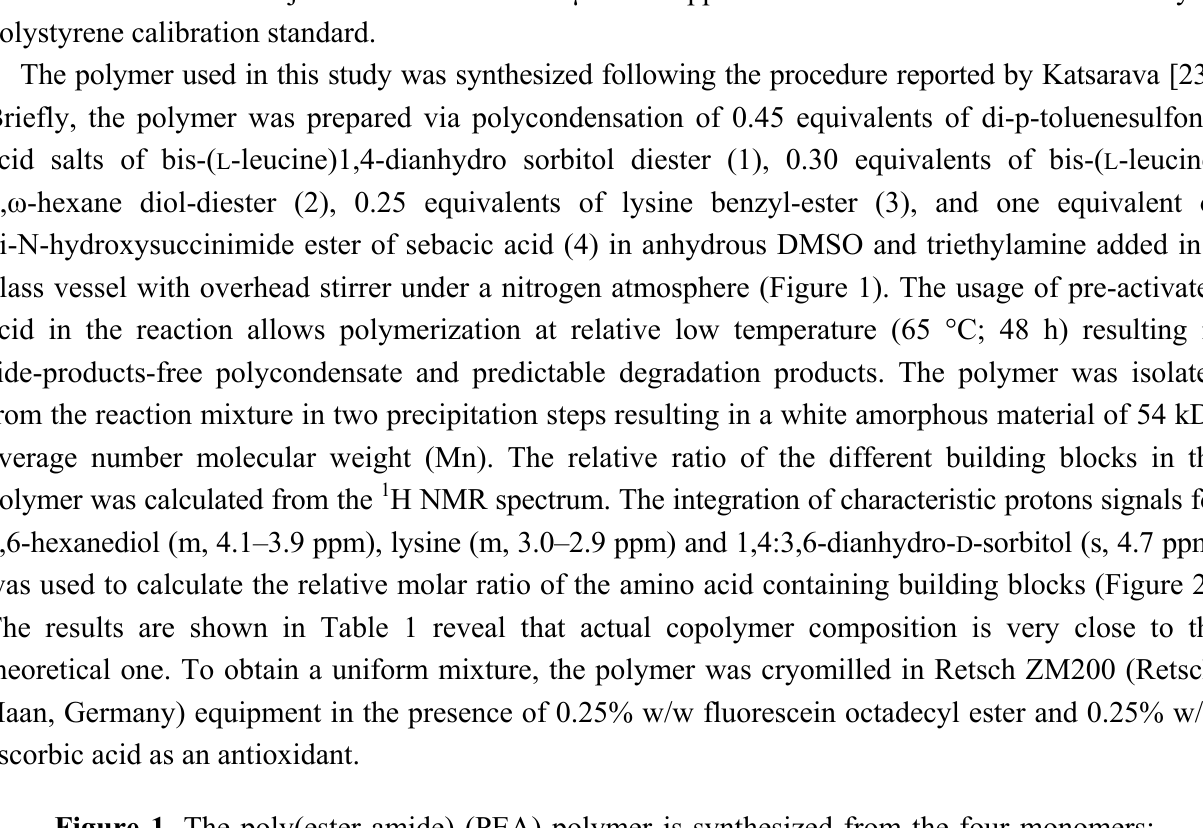
Figure 1. The poly(ester amide) (PEA) polymer is synthesized from the four monomers: bis-( L -leucine) 1,4-dianhydro sorbitol diester (1), bis-( L -leucine) α , ω -hexane diol-diester (2), lysine benzyl-ester (3), and di-N-hydroxysuccinimide ester of sebacic acid